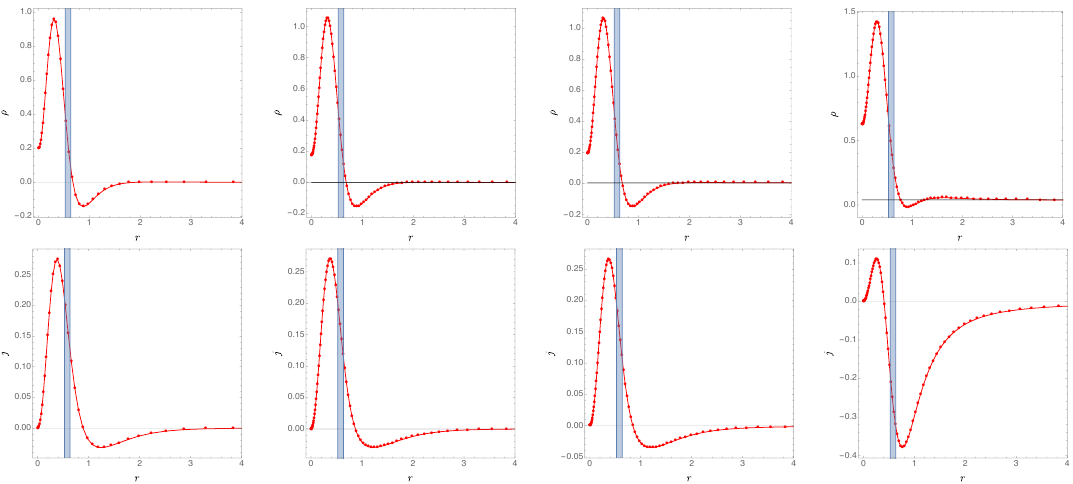
Figure 16 . The holographic energy density (top row) and holographic momentum density (bottom row) computed for n = 4 and (cid:12)xed a = 3 : 1 at four distinct temperatures. The shaded region denotes the ergoregion. From left to right we have 4 (cid:25)T= 3 = 0 ; 0 : 1 ; 0 : 5 ; 1. The horizontal solid black line in the holographic energy density plots indicate the value that these quantities take for a planar Schwarzschild black brane